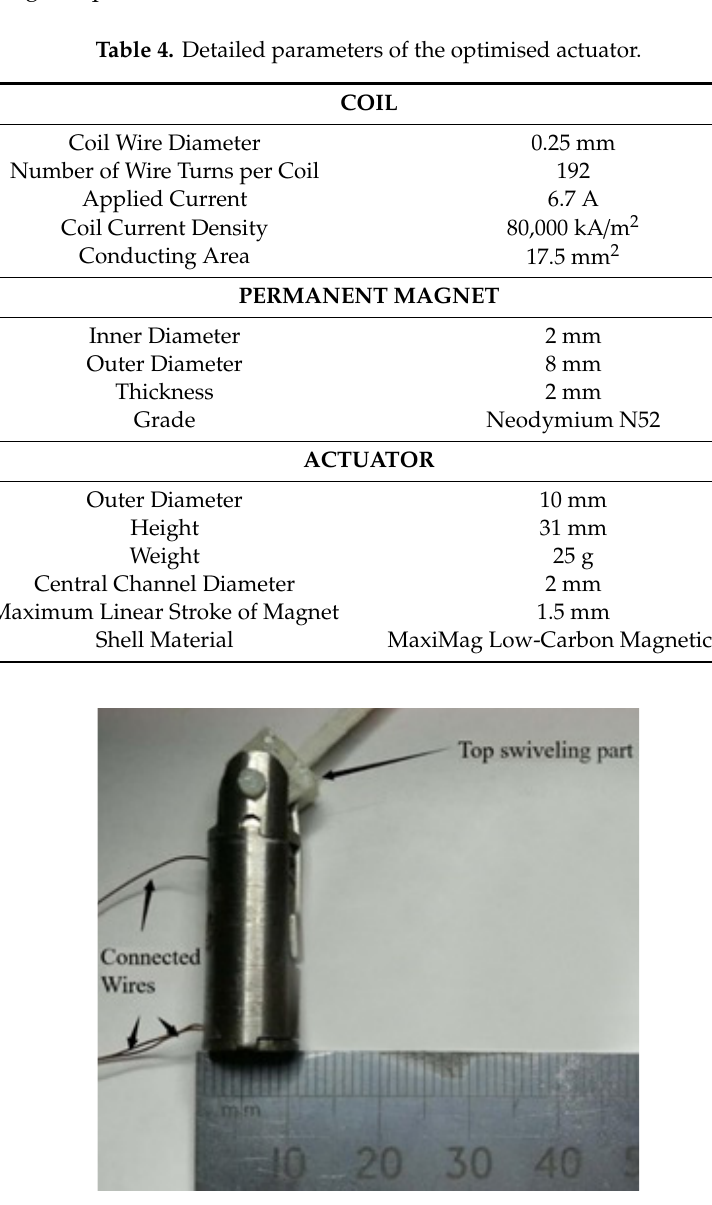
Figure 16. The new latching-type electromagnetic actuator shown on top of a ruler.